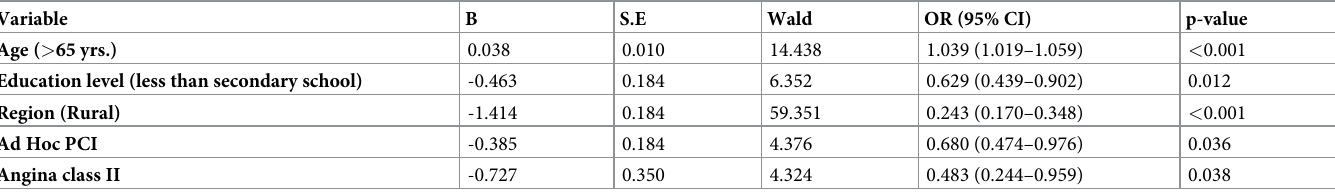
Beta (B), standard error (SE), dual antiplatelet therapy (DAPT), percutaneous coronary intervention (PCI), odds ratio (OR), confidence interval (CI). p-value < 0.05 taken as